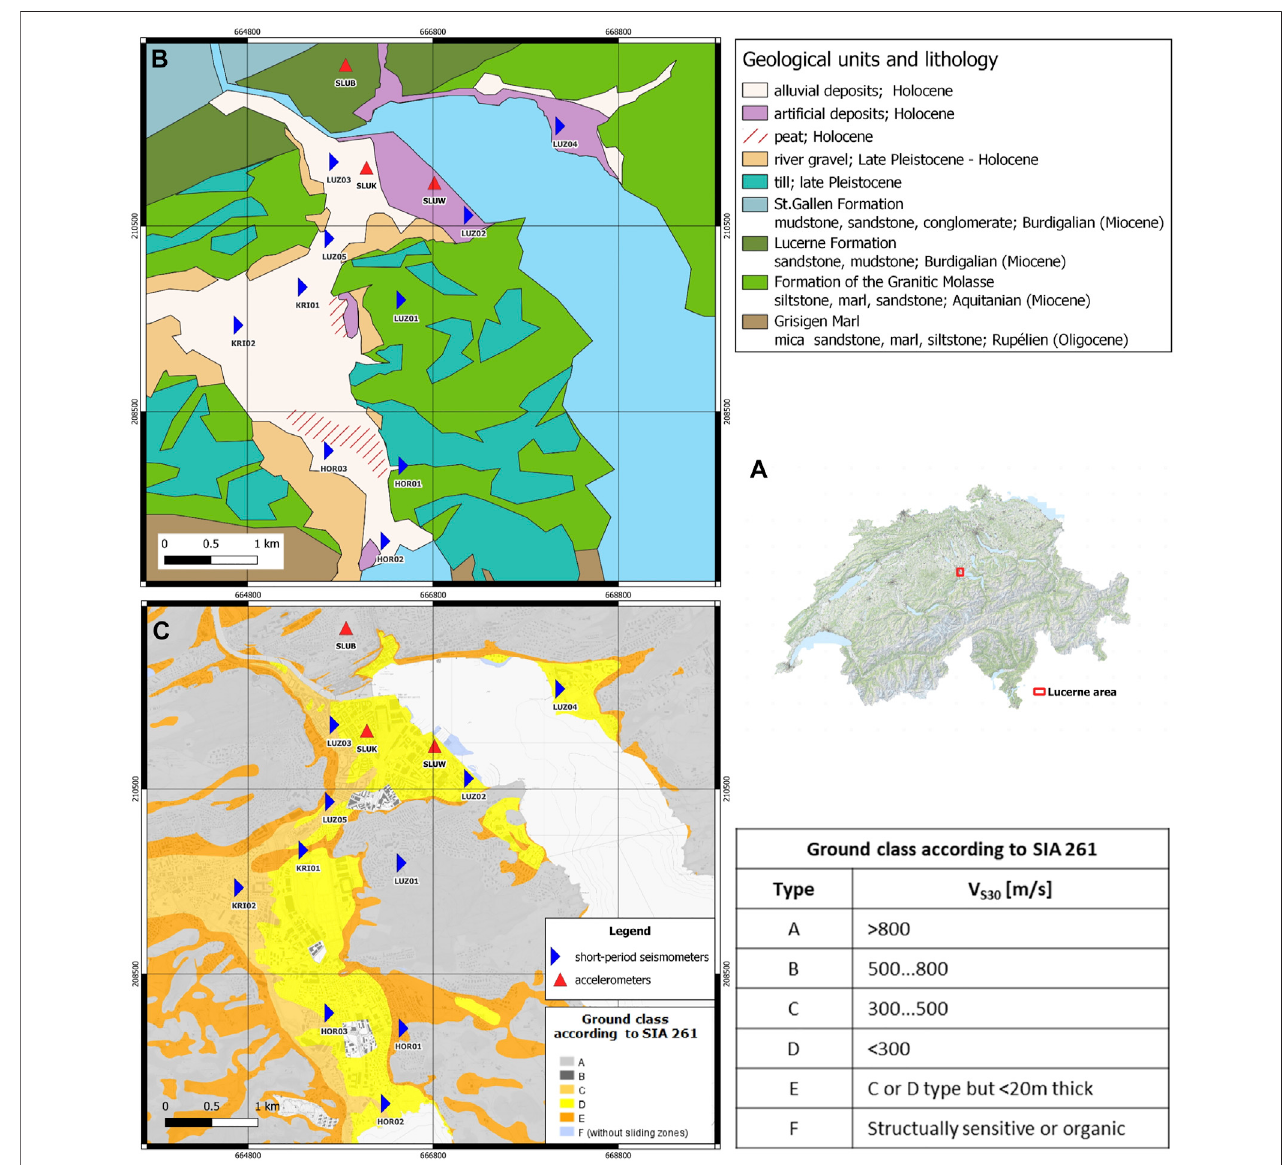
FIGURE 2 | (A) Red rectangle on the map of Switzerland shows the location of the investigated area. (B) Simpli fi ed geological map based on Geological Vector DatasetsGeoCover(s.geo.admin.ch/95a803e945) (C) Groundclasses intheLucerneareaaccordingtoSIA261(SIA,2020)(s.geo.admin.ch/96572c02d9).Stationsof local seismic monitoring networks are